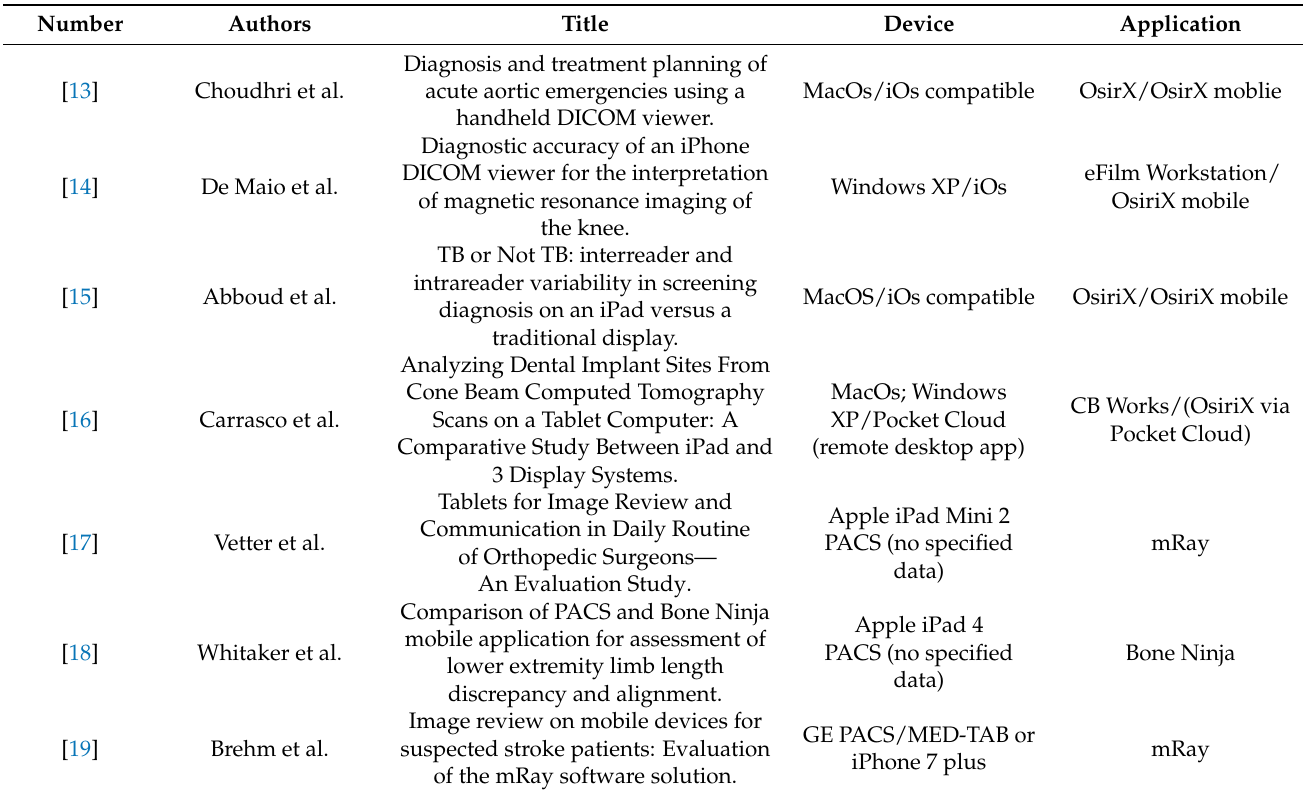
Table 1. Articles included in the systematic